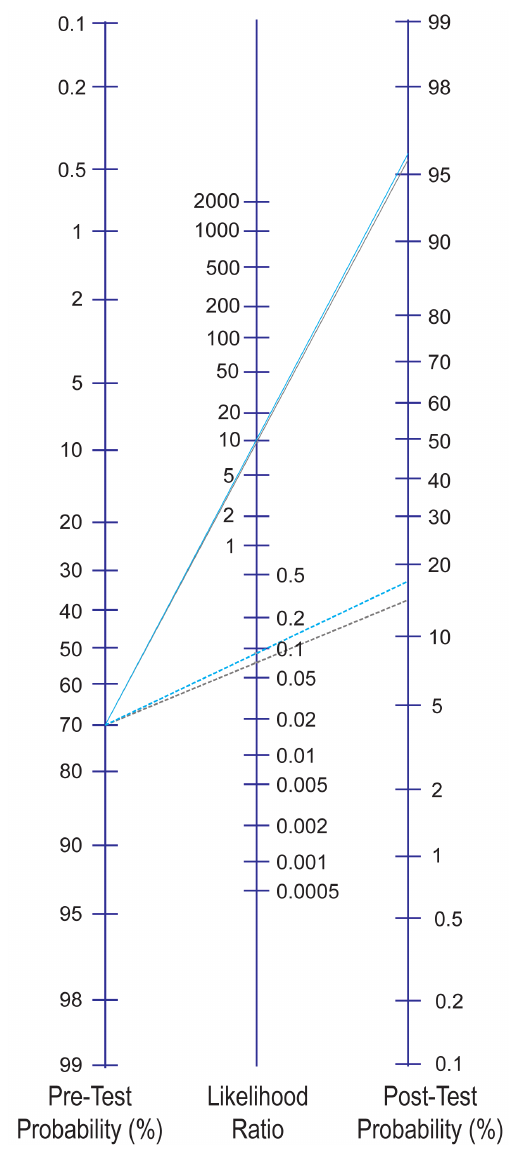
Fig. 3. Estimation of the post-test probability of prosthetic joint infection for the neutrophil or lymphocyte percentages when the pre-test probability is 70%; the blue lines are for the neutrophil percentage; the green lines are for the lymphocyte percentage; the dashed lines are for negative